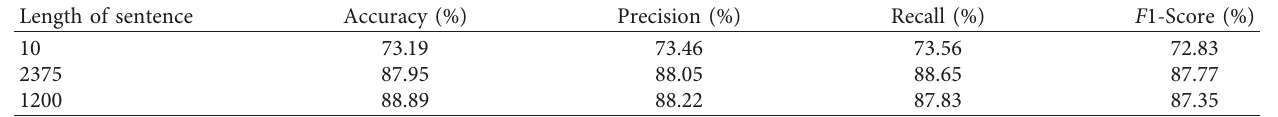
Table 1: Effect of the input statement using fixed-length dataset